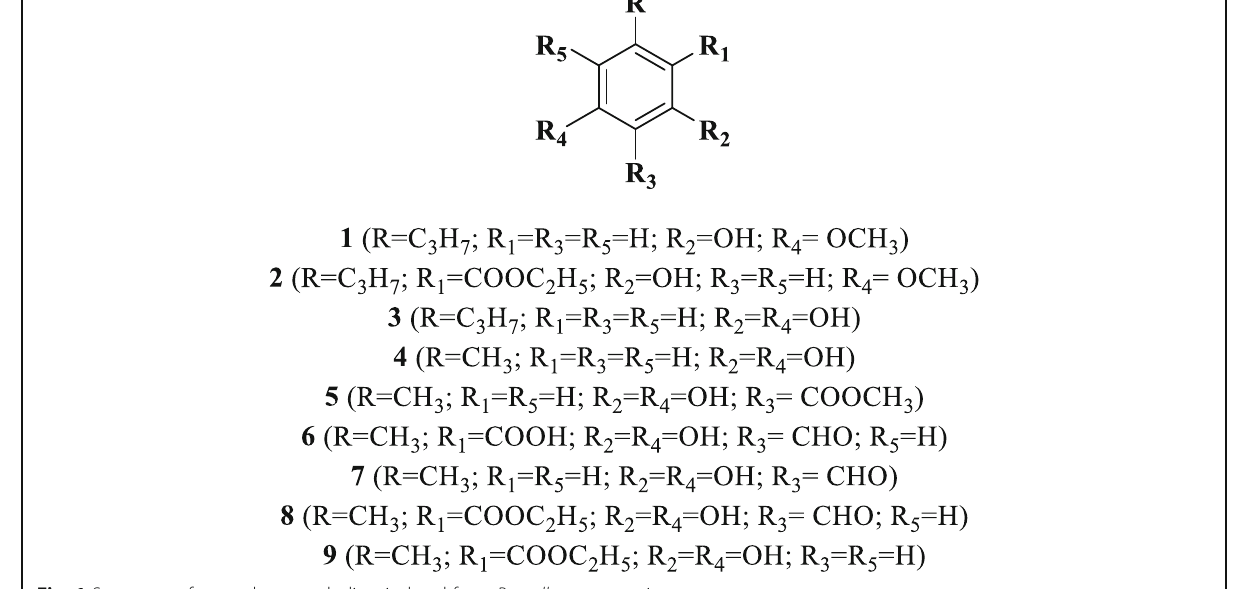
Fig. 1 Structures of secondary metabolites isolated from Roccella